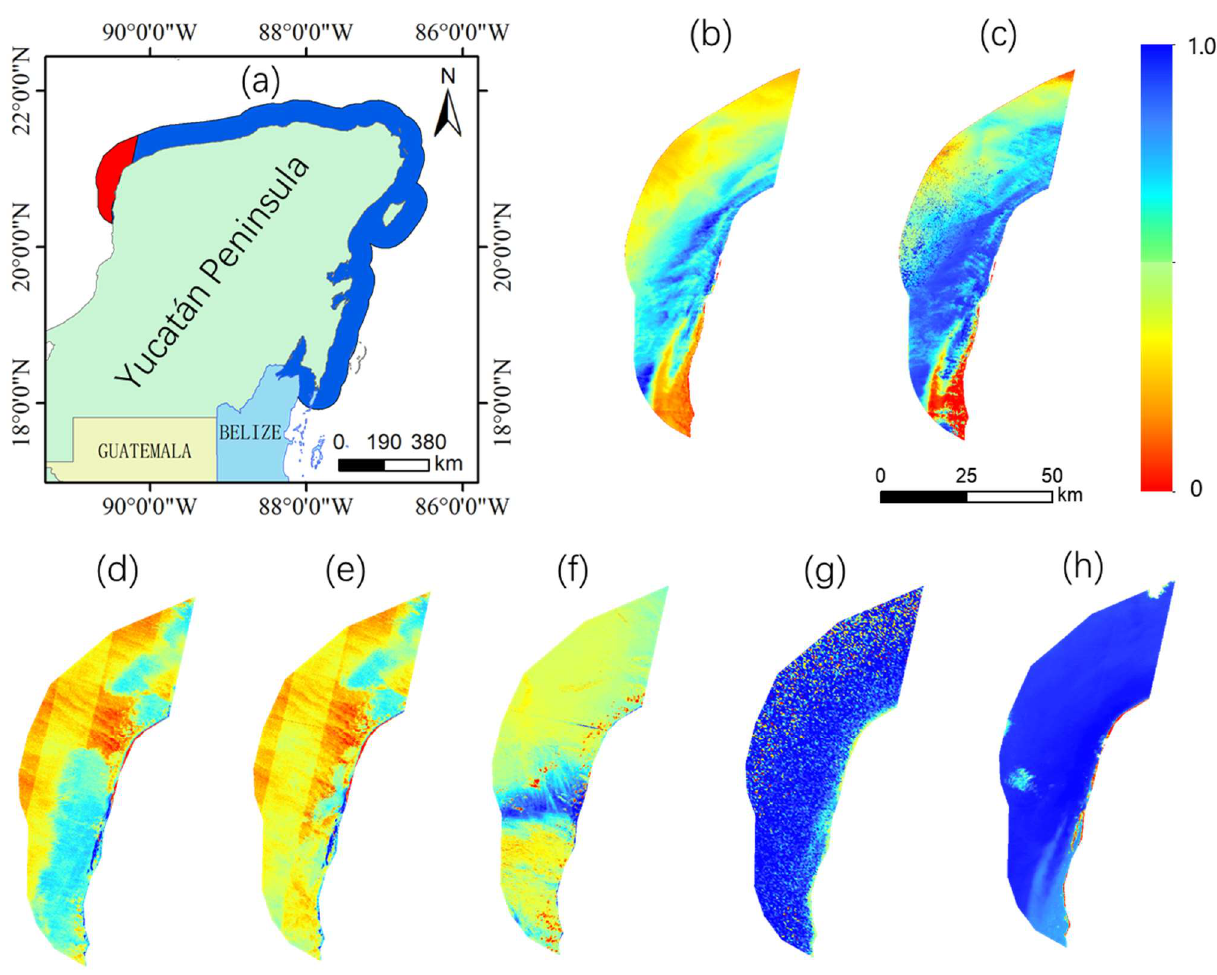
Figure 7. Comparison of restoration area with different images in 2016. ( a ) Restoration area in the study area; ( b ) post-restoration Landsat TOA NDWI image; ( c ) post-restoration Landsat SR NDWI image; ( d ) Landsat 8-day NDWI image; ( e ) Landsat 32-day NDWI image; ( f ) Landsat annual NDWI image; ( g ) MOD13Q1 NDWI image; ( h ) Sentinel-2 NDWI image.